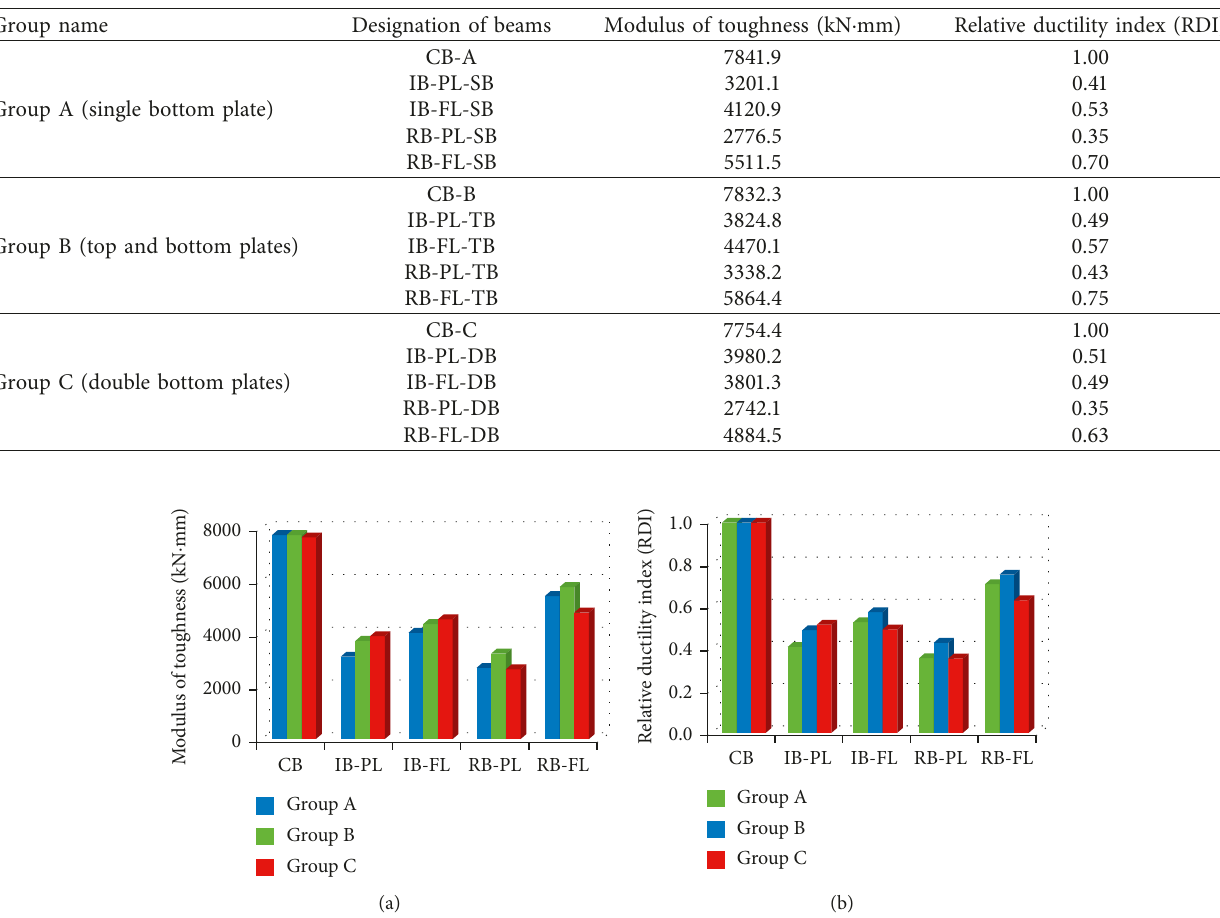
Table 8: Modulus of toughness and relative ductility.